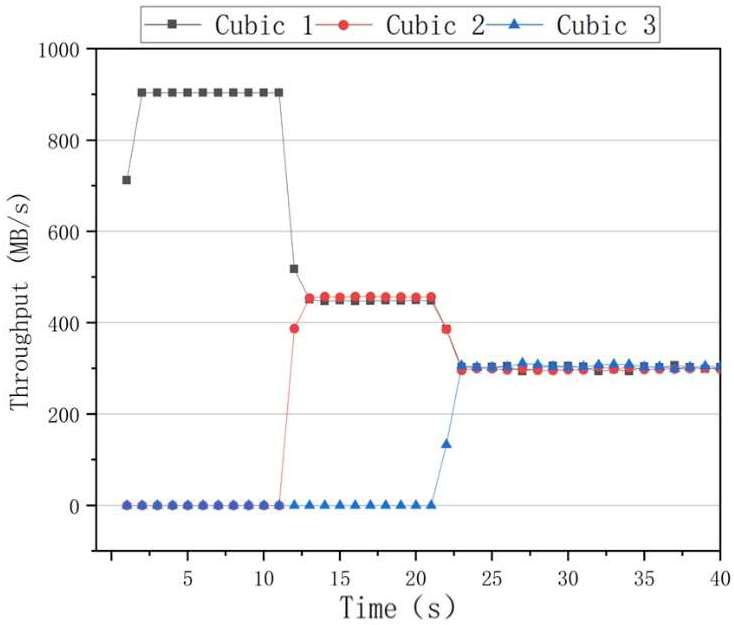
Figure 11. The fairness test curves of the Cubic congestion control algorithm at a network delay of 100 ms and a packet loss rate of zero.